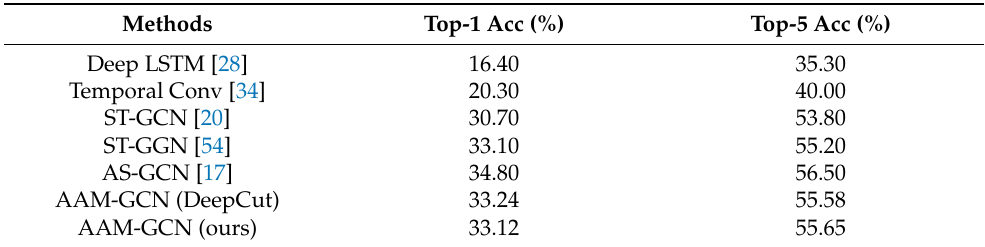
Table 1. The action recognition accuracy of top-1 and top-5 of various methods on the Kinetics dataset.